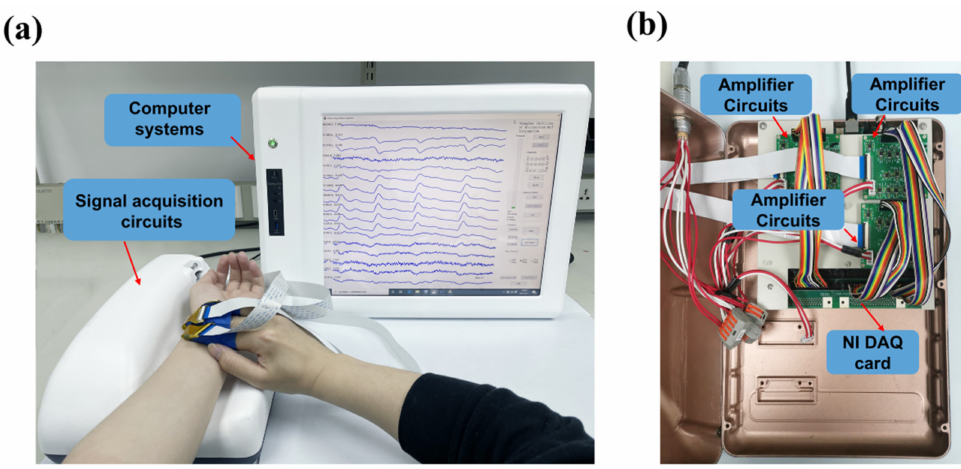
Figure 5. ( a ) The pulse acquisition system. ( b ) Close-up view of the signal acquisition